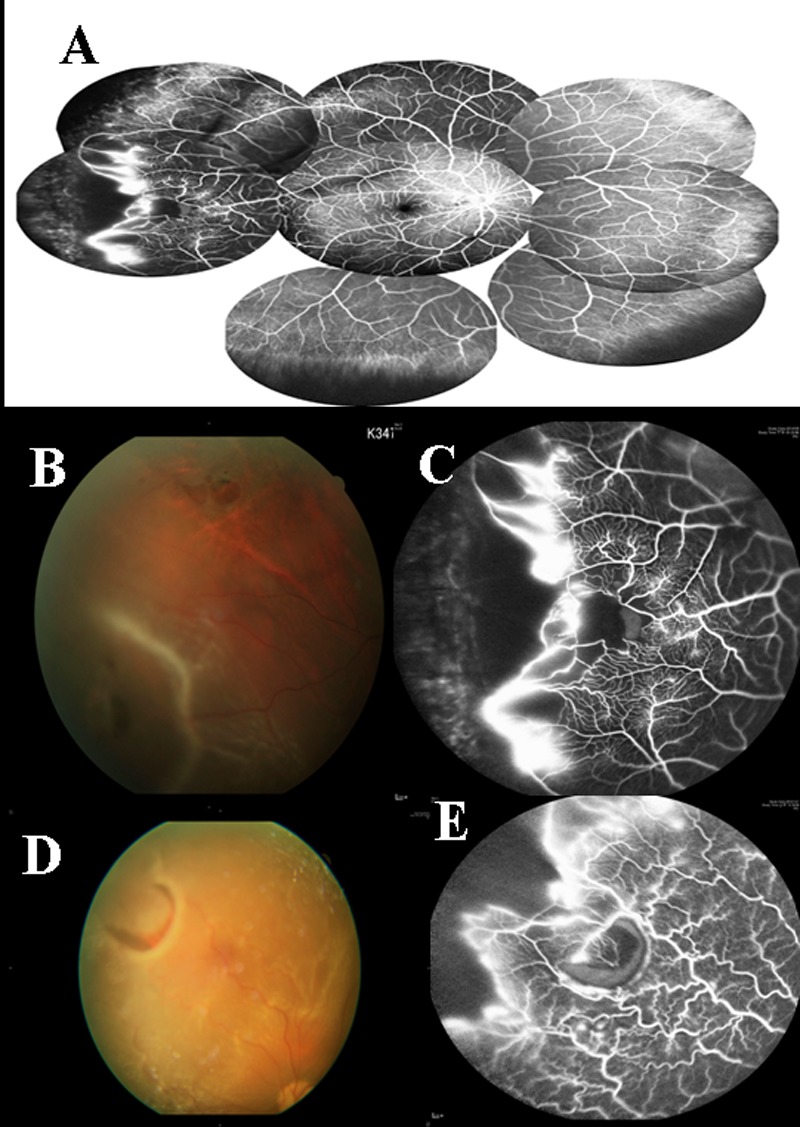
Color fundus and FA photos of group 4 eyes (A) Fluorescein angiography of group 4 vasculature. There is a V-shaped notch at peripheral retina, with peripheral anastomosing vasculature. Non-perfusion areas are noted inside the vascular arch. Wide area of peripheral non-perfusion is noted outside the temporal notch. Marked vascular leakage is noted at temporal anastomosing vessels. (B) Fundus photo of an eye with type 4 vascular pattern showing a tear at the temporal detached retina and 2 breaks associated with lattice degeneration at temporal upper attached retina. (C) Fluorescein angiography of the same eye, showing an avascular notch at temporal aspect and anastomosing vasculature. The tear is within the vascular loop, where the retina is non-perfused. (D) Fundus photo of a horse-shoe tear in an eye with type 4 vasculature. (E) Fluorescein angiography at the same location showing 2 V-shaped notches of the avascular zone. The tear is within a vascular loop, where the retina was partially perfused. Marked leakage was noted at the anastomosing vasculature.